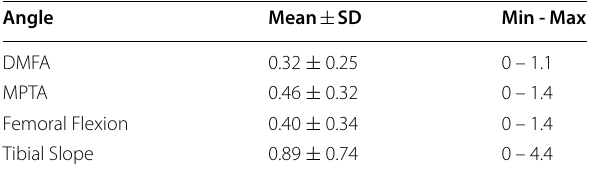
Table 5 Comparisons between the validated and planned (validated – planned) angles for the mastered raTKA group. Reported as absolute